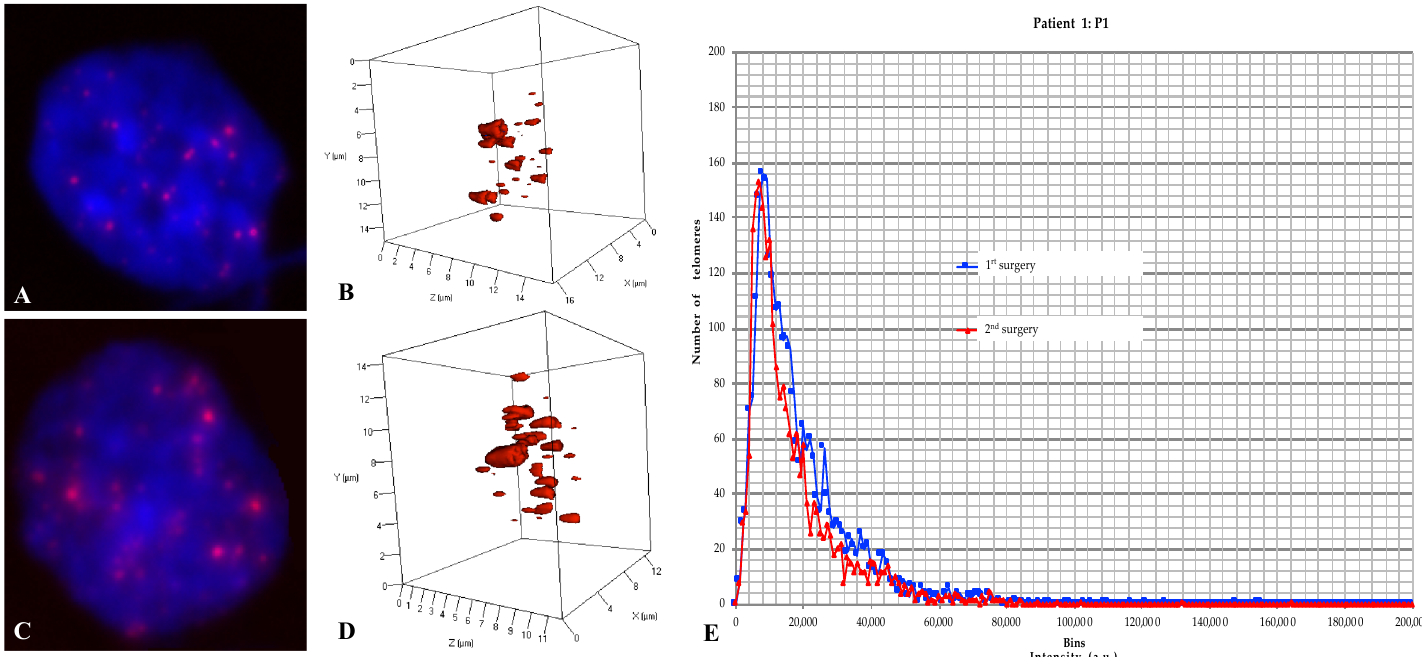
Figure 3. In an example of a group-2 patient (from patient 1: P1), a representative nucleus (1 × 1000 magnification) with 2D QFISH at first surgery ( A ) and at second surgery ( C ); representative nucleus with 3D QFISH at first surgery ( B ) and at second surgery ( D ); and a representative combined 3D telomere profiles displaying the distribution of the total number of signals (total number of telomeres) versus their intensities (telomere length) at both surgeries, respectively ( E ) for patients with long-term recurrence (P1: TTP = 894 days and OS = 5212